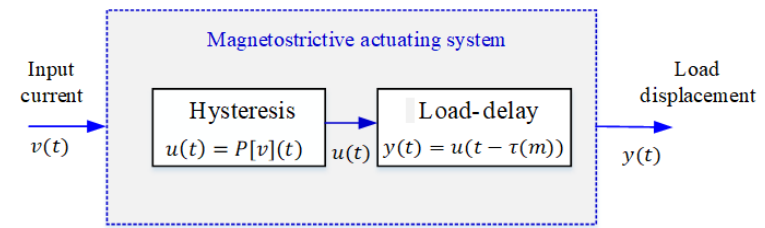
Figure 6. The structure of the modified PI hysteresis model with load-dependent